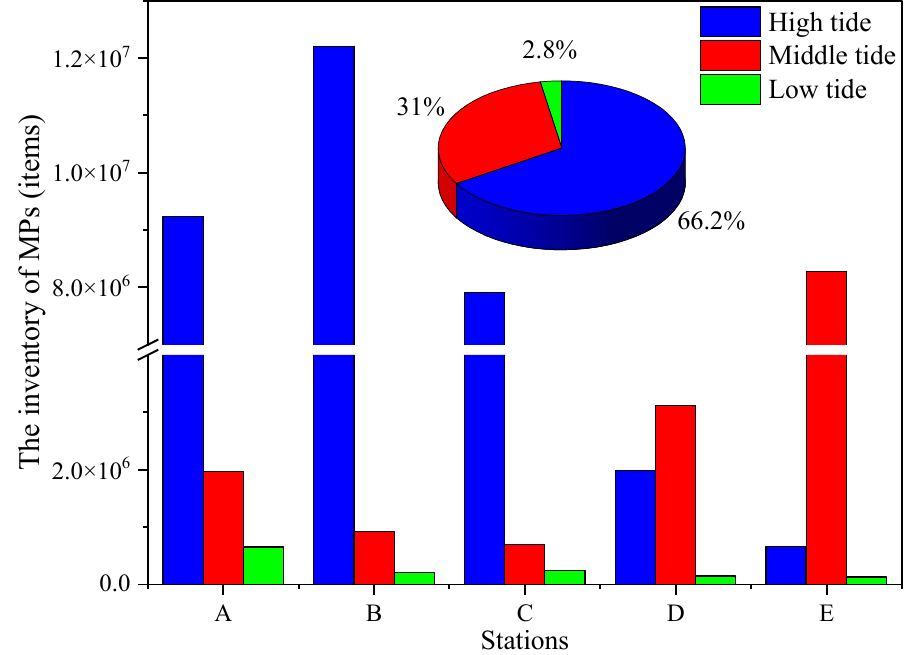
Figure 6. Inventory of MPs in the bathing seawater affected by the ebb tide.